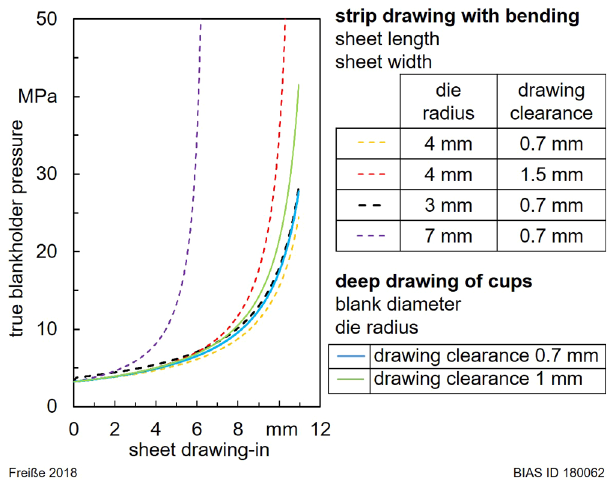
Fig. 5. Example on calculated blankholder pressures up to a sheet draw-in of 11 mm.